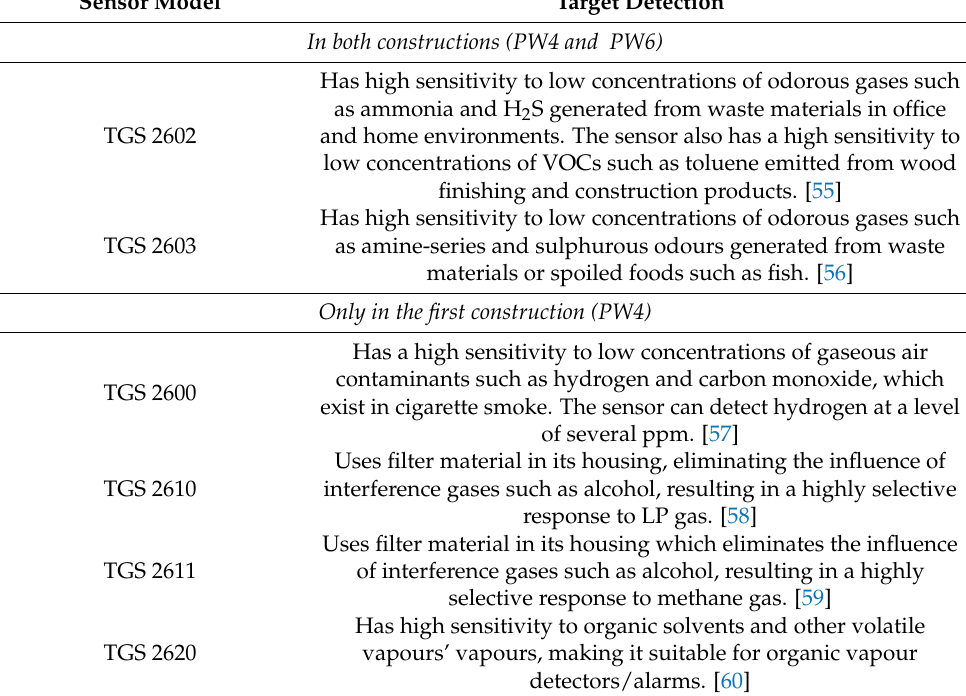
Table 1. A list of sensor models used in e-nose devices and the odours and gases targeted. Sensor